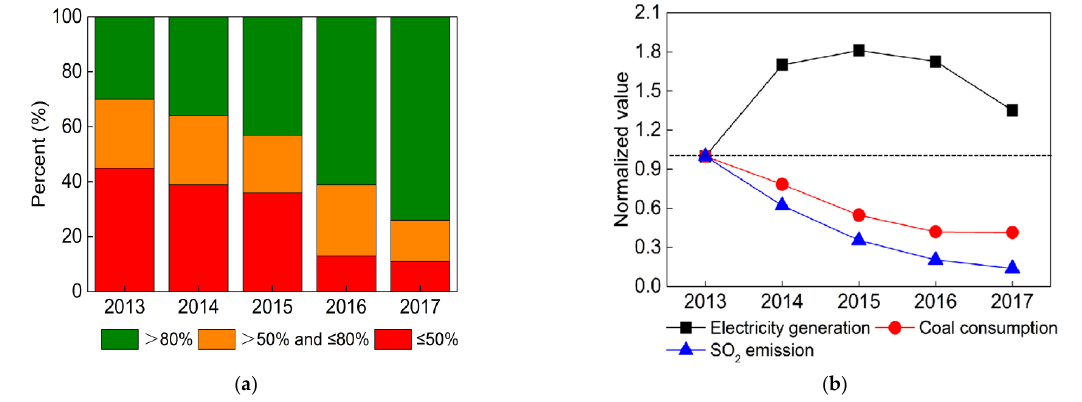
Figure 4. Trends in ( a ) desulfurization efficiency for power plants; ( b ) SO 2 emission and related activity data for power plants, the related data were normalized to the year 2013.